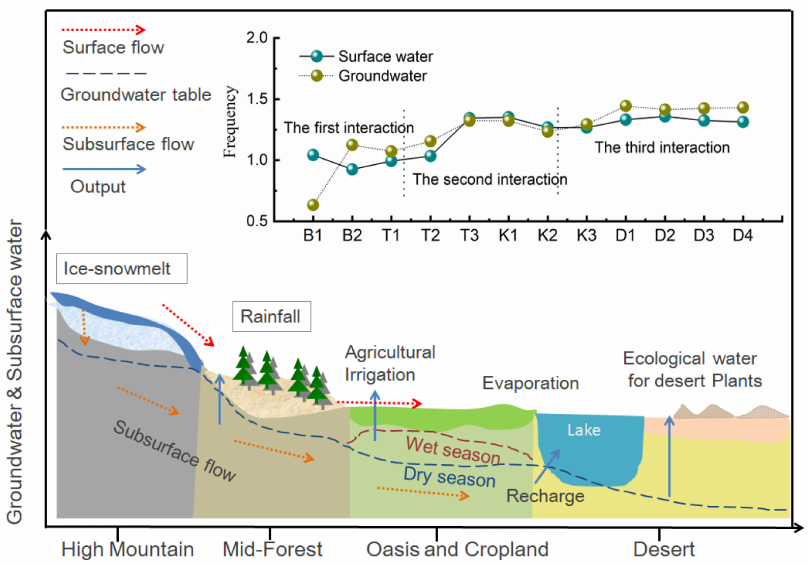
Figure 6. Sketch of hydrologic cycle in Kaidu River basin, groundwater and surface water interaction relationship based on mass